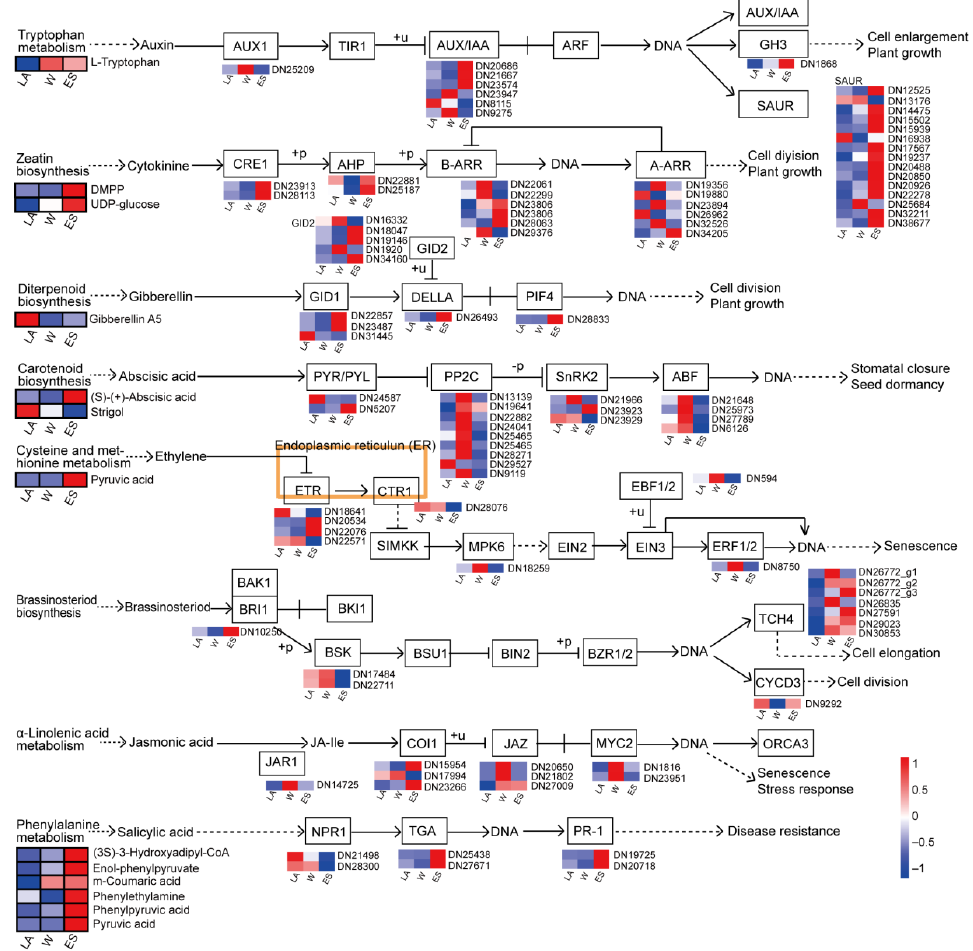
Figure 7. Plant hormone signal transduction-related genes that were differentially expressed in overwintering C. fortunei . Normal arrows indicate promotion, and T-shaped arrows indicate inhibition. The brown box indicates endoplasmic reticulum (ER). After normalizing the row data, boxed heatmaps indicate the metabolite contents, and unframed heatmaps represent unigene expression levels. Red represents highly expressed unigenes/high metabolite contents, and blue represents unigenes with low expression/low metabolite content. The text below the heatmap indicates the sampling time (ES, early spring; LA, late autumn; and W, winter). Gene abbreviations are as follows: A-ARR, two-component response regulator ARR-A family; ABF, ABA responsive element binding factor; AHP, histidine-containing phosphotransfer protein; AUX1, auxin influx carrier; AUX/IAA, auxin-responsive protein IAA; ARF, auxin response factor; BAK1, brassinosteroid insensitive 1-associated receptor kinase 1; B-ARR, two-component response regulator ARR-B family; BKI1, BIN2, brassinosteroid insensitive 2; BRI1 kinase inhibitor 1; BRI1, brassinosteroid insensitive 1; BSK, BR-signaling kinase; BSU1, serine/threonine-protein phosphatase BSU1; BZR1_2, brassinosteroid resistant 1/2; CTR1, serine/threonine-protein kinase; COI-1, coronatine-insensitive protein 1; CYCD3, cyclin D3; DELLA, Asp-Glu-Leu-Leu-Ala protein; EBF1_2, EIN3-binding F-box protein; EIN2, ethylene-insensitive protein 2; ERF1, ethylene-responsive transcription factor 1; ETR, ethylene receptor; GH3, growth hormone response; GID1, gibberellin -insensitive dwarf1; GID2, F-box protein GID2; JAR1, jasmonic acid-amino synthetase; JAZ, jasmonate ZIM domain-containing protein; MPK6, mitogen-activated protein kinase 6; MYC2, myelocytomatosis oncogene homolog 2; NPR1, nonex- pressor of PR-1; ORCA2_3, AP2/ERF-domain transcription factor; PIF4, phytochrome-interacting factor 4; PP2C, protein phosphatase 2C; PR1, pathogenesis-related protein 1; PYR/PYL, pyrabactin resistance/pyr1-like; SIMKK, mitogen-activated protein kinase kinase 4/5; SnRK2, serine/threonine-protein kinase SRK2; SAUR, small-auxin-up-RNA; TCH4; touch-inducible gene; TGA, TGACG Motif-binding factor; TIR1, transport inhibitor response 1